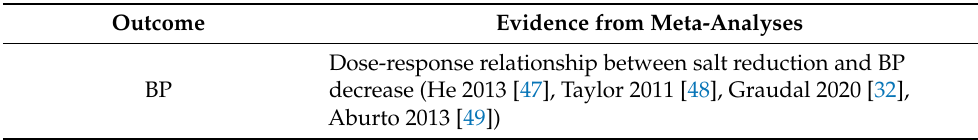
Table 1. Summary of the main evidence reported by meta-analyses regarding the effect of salt restriction upon the main cardiovascular and renal